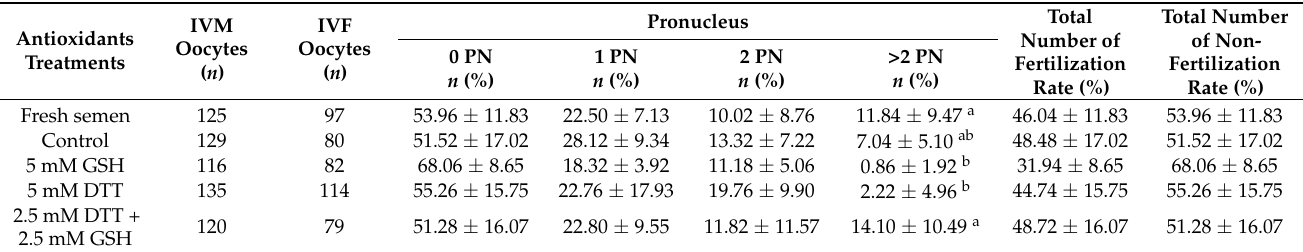
Table 8. The effect of antioxidants on sperm fertilization ability following in vitro maturation of gilts oocytes in vitro fertilization (mean ±